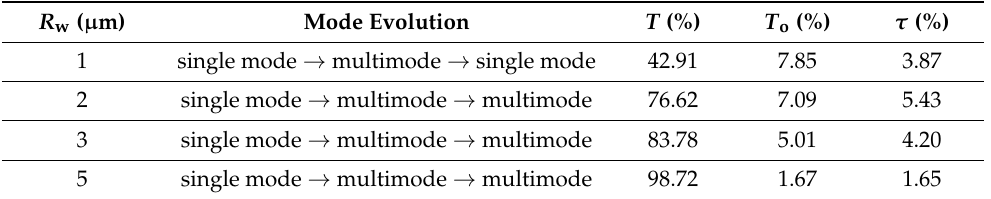
Figure 4. Schematic of the modal evolution in the transition region with ( a ) R w = 1 µ m; ( b ) R w = 2 µ m; ( c ) R w = 3 µ m; ( d ) R w = 5 µ m; ( e ) calculated modes proportion; ( f ) light transmittance, evanescent power ratio, evanescent efficiency in the waist with different R w . Table 1. Calculated light transmittance T , evanescent power ratio T o , evanescent efficiency τ